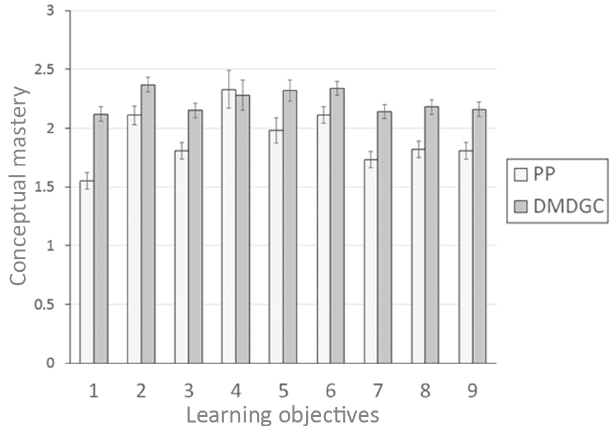
Figure 3. Conceptual mastery scores for each learning objective by group. Error bars represent the standard error of the mean. (1) Rec- ognizes that urbanization can increase impervious land cover and increase runoff and flooding, (2) explains that higher rainfall dura- tion and intensity, combined with high soil moisture or impervious land cover, causes flooding, (3) uses correctly in context the vocab- ulary of land cover change, rainfall and runoff processes, and flood discharge and stage, (4) explains the effect of decadal timescale LULC change on flooding, (5) recognizes that maximum discharge rates determine flooding (hydrographs), (6) explains the tools used in flood management, (7) identifies flood management agency roles and responsibilities, (8) recognizes the value of geoscience knowl- edge for flood management, and (9) explains the utility of mathe- matical flood